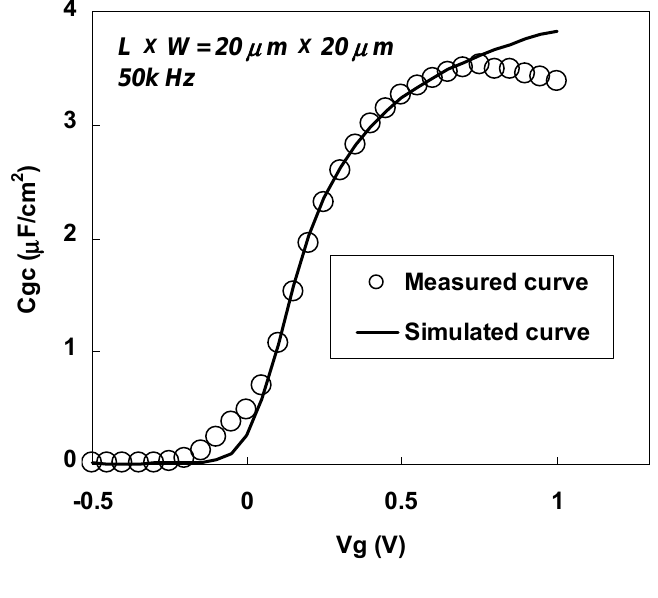
Figure 42. Cgc-Vg characteristics for an n-MOSFET annealed at 450 °C after sulfur